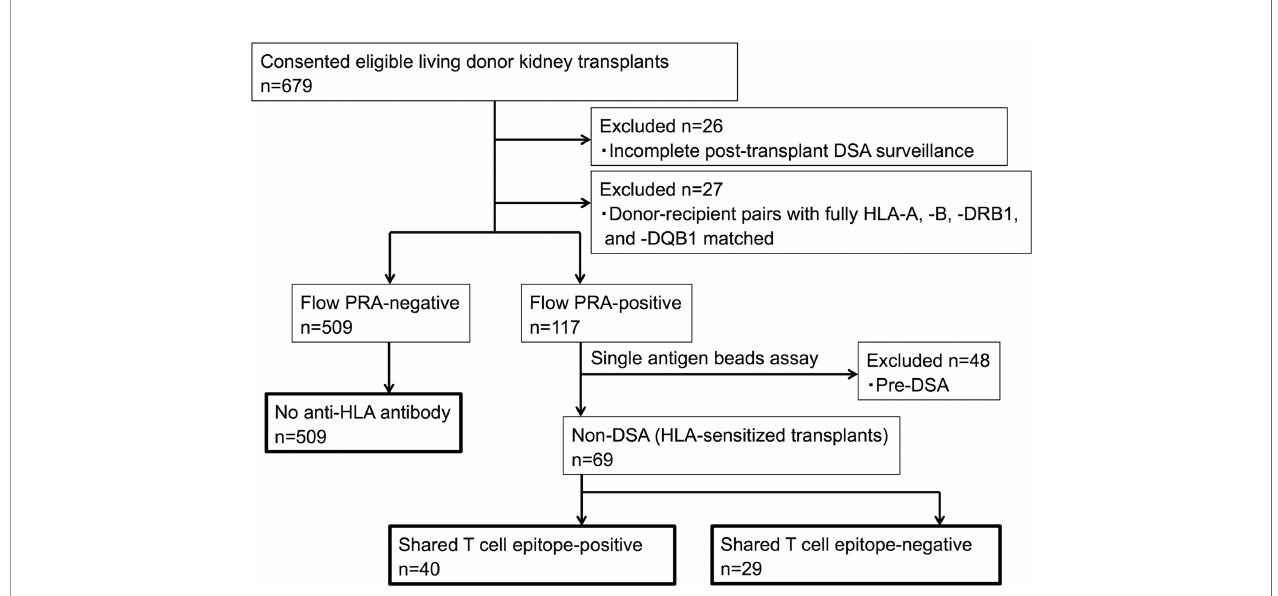
FIGURE 2 | Patient fl owchart. Pre-DSA, preformed-donor-speci fi c anti-HLA antibodies; non-DSA, non-donor-speci fi c anti-HLA antibodies; PRA, panel reactive